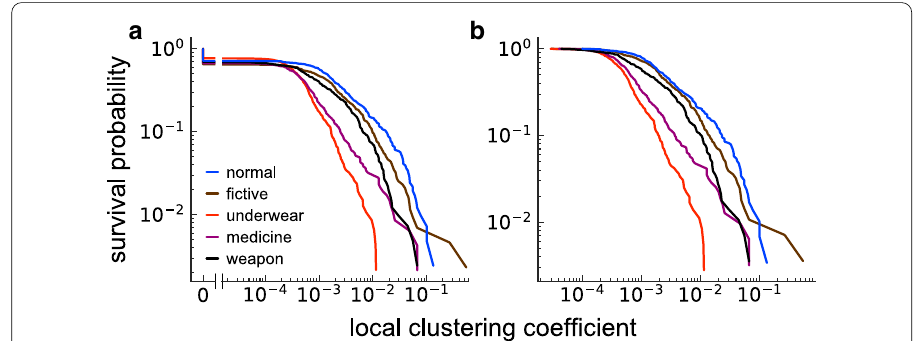
Fig. 6 Local clustering coefficient for each user type. a Survival probability. b Survival probability conditioned on C i >